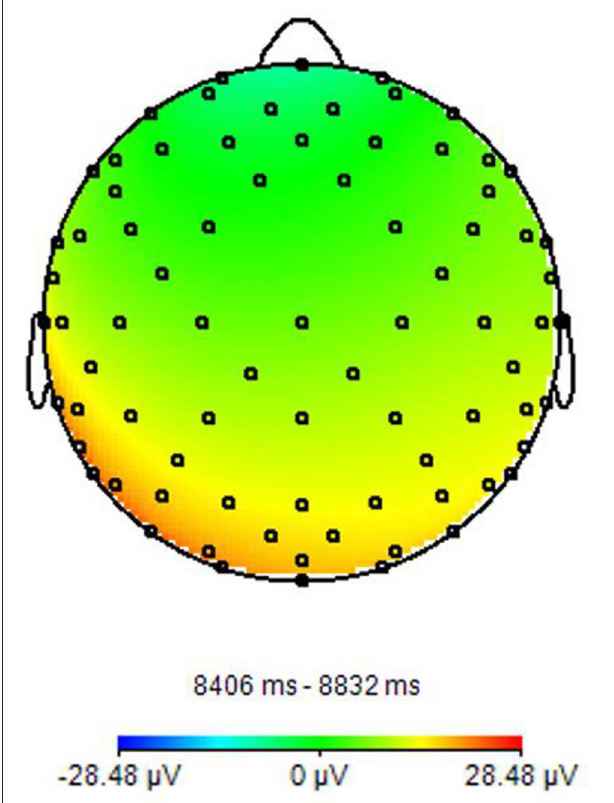
FIGURE 1 | EEG power spectrum. It presents a Topographic representation of Alpha power activity. Image obtained on a 40 years-old healthy volunteer with hybrid EEG-fMRI system and included for illustrative purpose